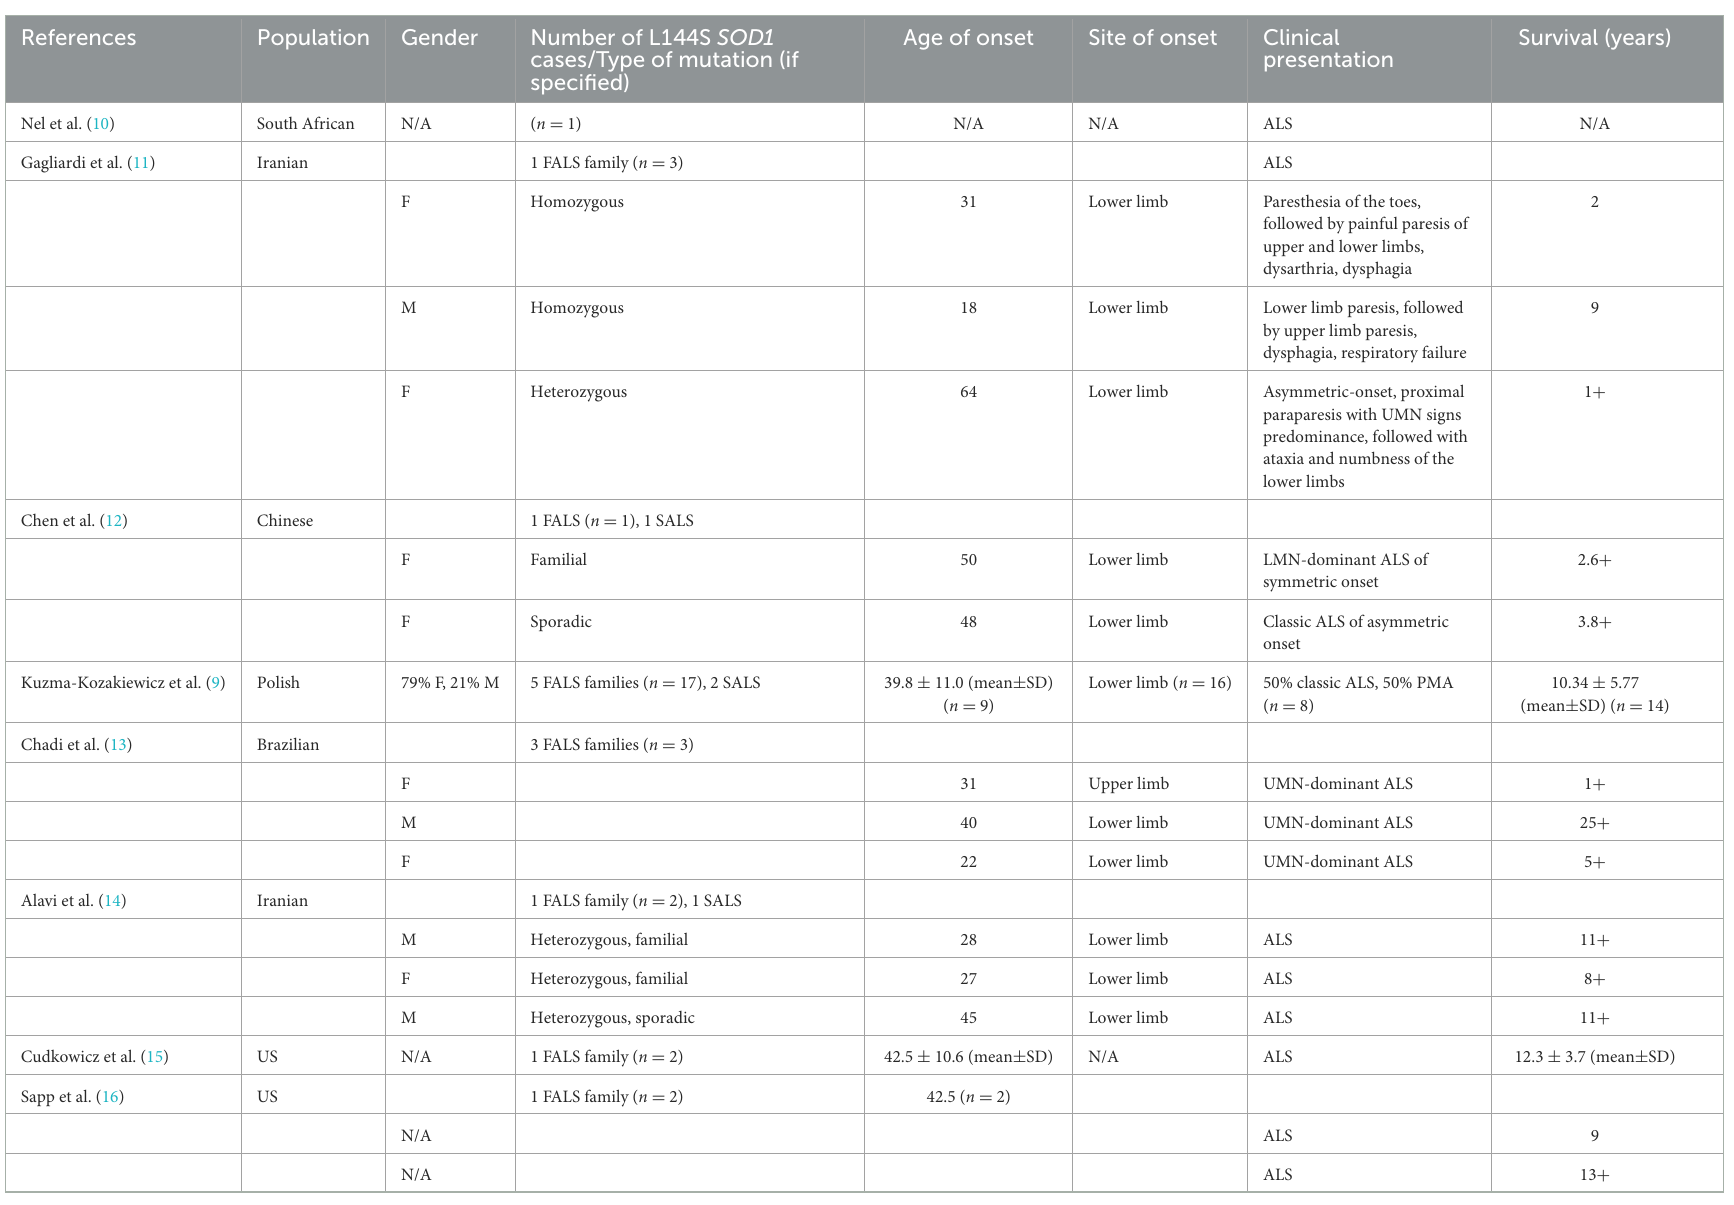
TABLE 2 Review of L144S SOD1 cases reported in the